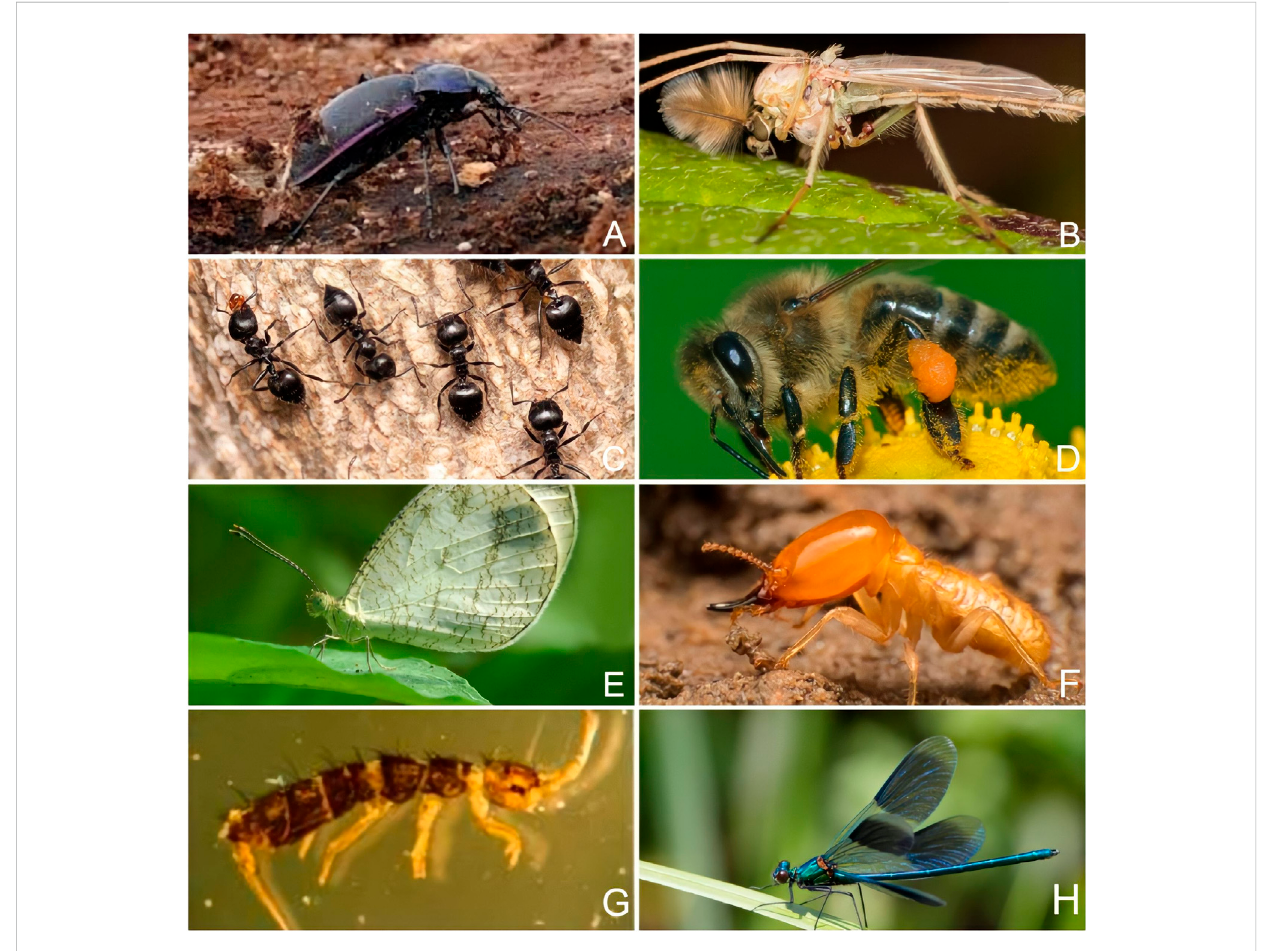
FIGURE 4 Major bioindicator insects. (A) Beetle, (B) Chironomid, (C) Ant, (D) Bee, (E) Butter fl y, (F) Termite, (G) Springtail, (H) Dragon fl y.